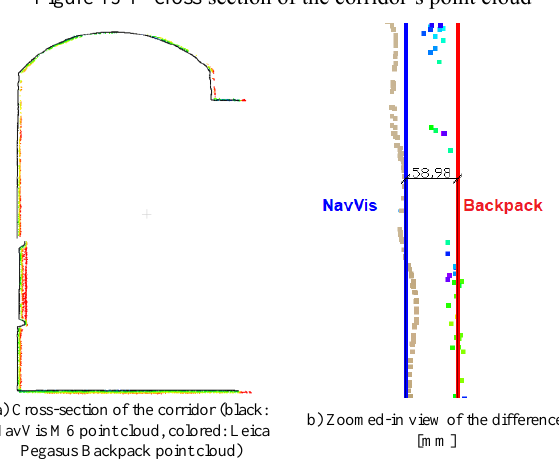
Figure 13 1 st cross-section of the corridor’s point cloud